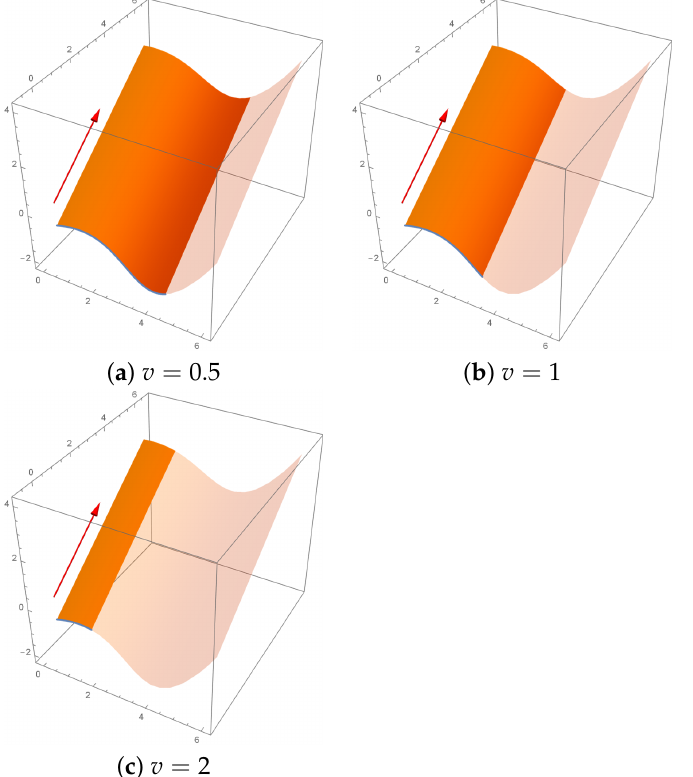
Figure 20. Extruded surface generated by cubic fractional Bézier curves with different fractional